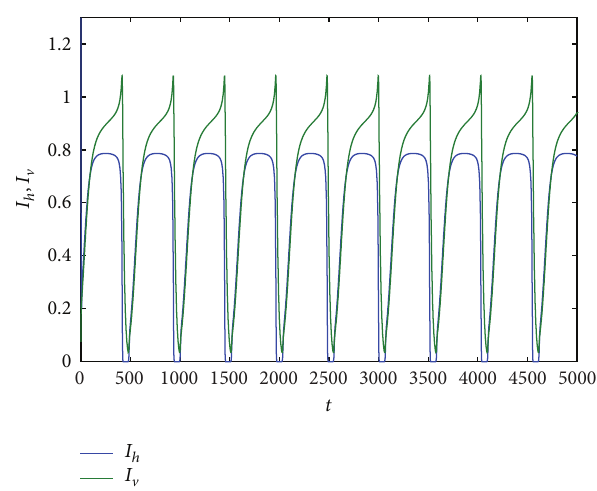
Figure 6: Trajectory picture with time 𝑡 when 𝑟 = 0.8 , 𝐾 = 10 , = 1 , 𝑎 = 1 , 𝑎 = 0.3 , 𝑑 𝛽 1 1 2 = 0.06 , 𝛽 = 0.26 , and 𝑁 𝑑 V 2